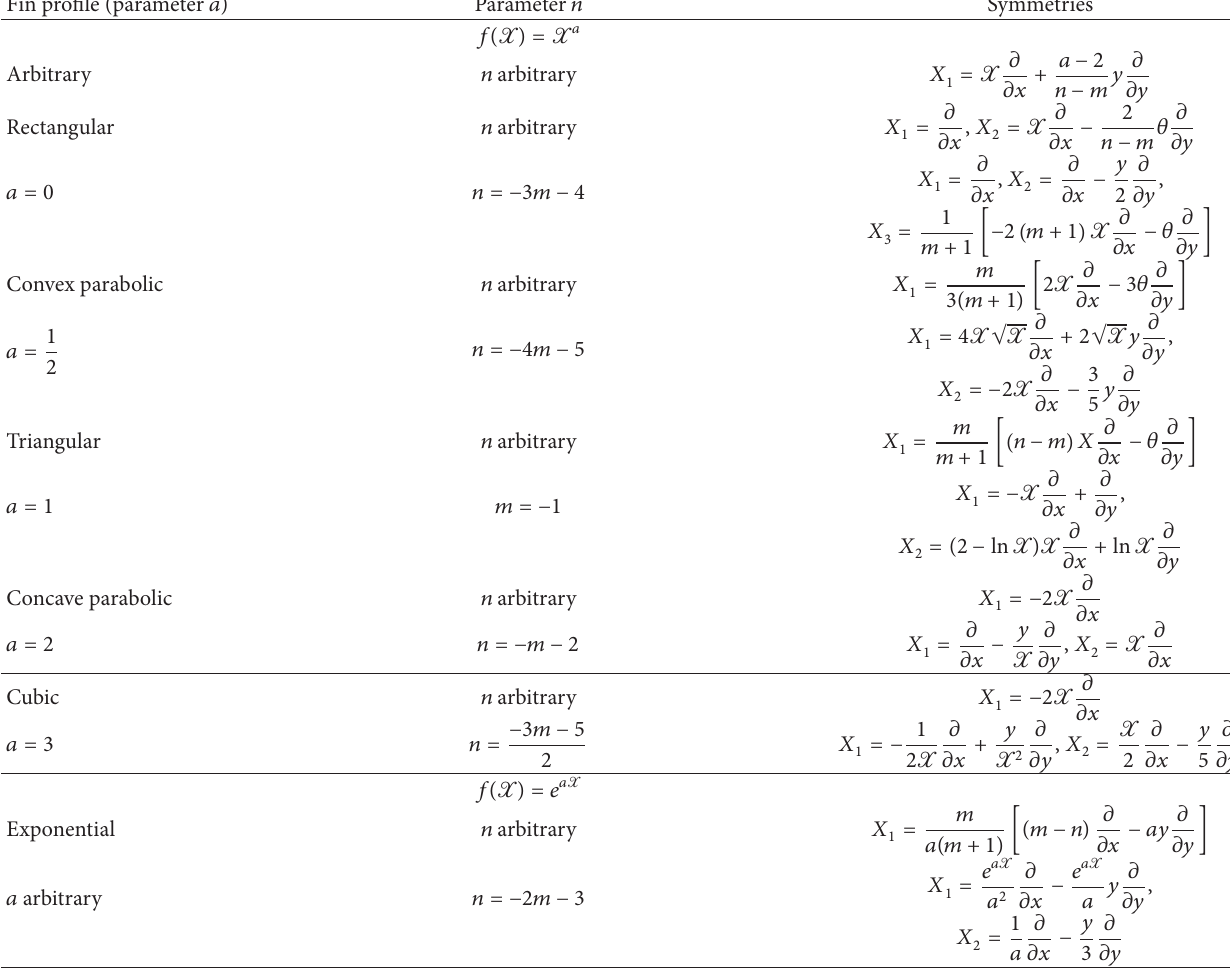
Table 9: Modified symmetries for 𝑓( X ) where X = 𝑥 + 1 and 𝑚 ̸=𝑛, 𝑛 ̸= − 1